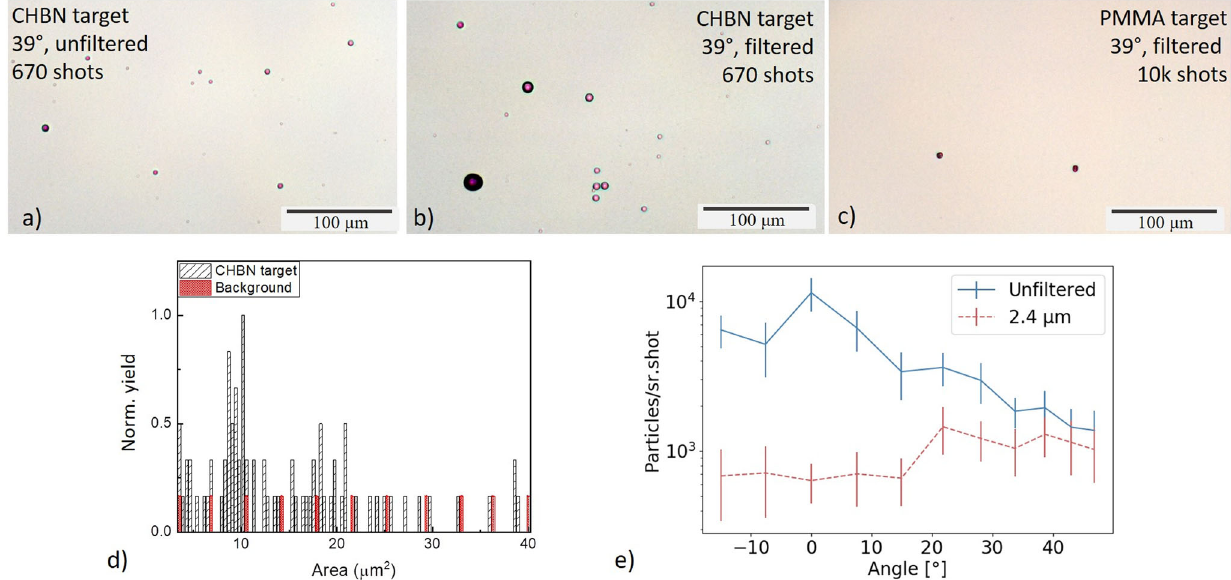
Fig. 2 CR39 measurements and results. a Example of the un fi ltered CR39 region at 0° in the case of CH-BN target after 3 h of etching, showing tracks from various particles emitted from plasma. The total number of accumulated shots is 670. b Example of the irradiated CR39 detector located at 39° and fi ltered by a 2.4- μ m thick Al foil in the case of CH-BN target after 3 h of etching. All the dots are ascribable to alpha particles of different energies (larger dots correspond to low-energy alpha particle loosing most of their energy in the Al fi lter). c Example of the CR39 detector irradiated and etched under similar conditions as in a) in the case of reference PMMA (polymethyl methacrylate) target (no boron content). The total number of shots on the target was 10 4 . The two tracks visible in the image are within the background level. d Histogram showing the area distribution of the detected particle tracks for all the CR39 samples under conditions described in a ). The background in fl uence is highlighted in red and is considered as 10 particles per statistics. e Angular distribution comparison of particles detected by CR39 in the un fi ltered (blue solid line) and fi ltered (red dashed line) regions. The error bars are given by the standard deviation error. The background (80 particles/sr/shot) is already subtracted from the passing the fi lter under high irradiation fl ux. A fi ltered segment of the reference CR39 at the same angle (39°) is presented in Fig. 2c) showing only a few dots in the image, which is comparable to the natural background level (observed on unexposed CR39 samples).